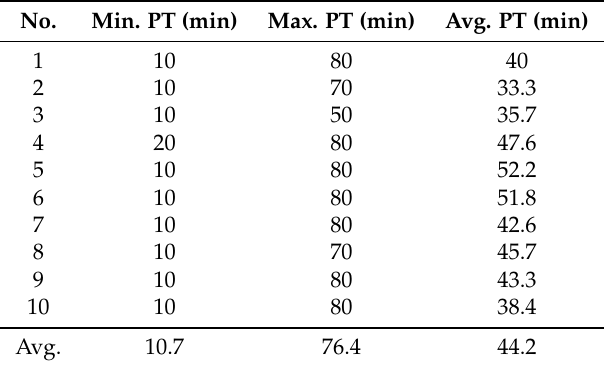
Table 8. Prediction time in advance for different